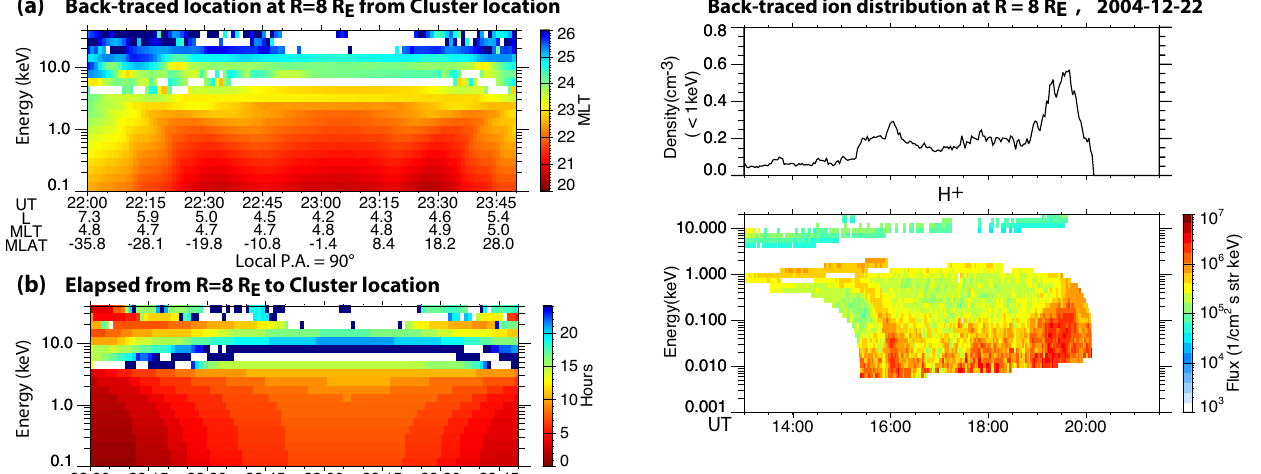
Fig. 4. Number density (upper panel) and energy-time flux spectro- gram (lower panel) of the estimated H + source that is obtained by applying the backward phase-space mapping to the observed pro- tons during 23:07 ∼ 23:40UT (Southern Hemisphere only) shown in Fig. 2. We did not use the data before 23:07UT to remove con- tamination from radiation belt particles. The assumed electric field and magnetic field are described in Sect.